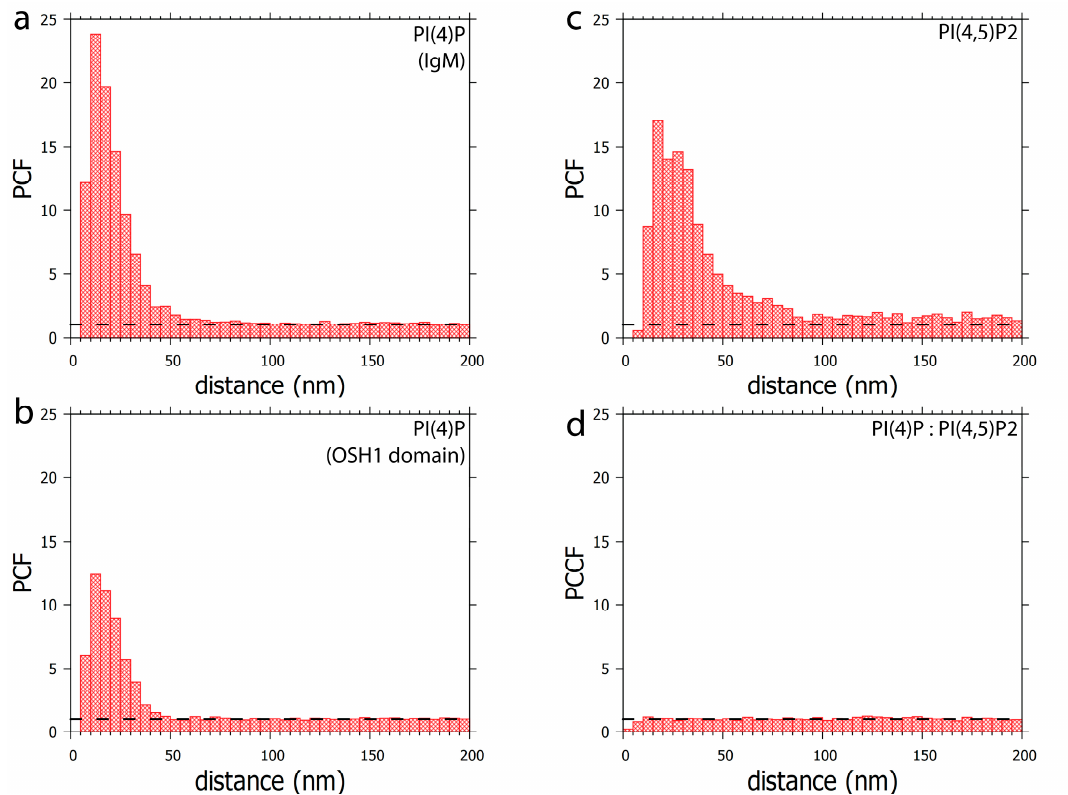
Figure 5. Clustering patterns of ( a ) PI(4)P labelled with anti-PI(4)P antibody or ( b ) PI(4)P labelled with OSH1-PH domain. The foci formed by PI(4)P are up to 50 nm in size. ( c ) Clustering pattern of PI(4,5)P2 labelled with anti-PI(4,5)P2 antibody. The foci formed by PI(4,5)P2 are up to 100 nm in size ( d ) Co-localisation analysis of PI(4,5)P2 with OSH1-PH labelling (Figure 4). PI(4)P does not specifically co-localise with PI(4,5)P2. PCF—pair correlation function, PCCF—pair cross-correlation function. Dashed lines mark the value of functions equal to 1, which corresponds to a random distribution.